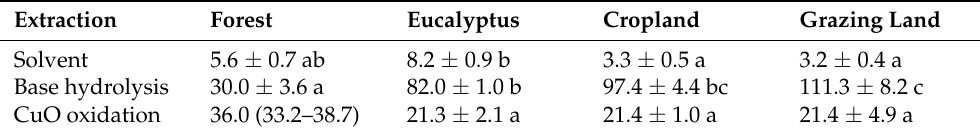
Figure 1. Carbon (C) and nitrogen (N) contents (%) at 0–10 cm soil depth in four land-use systems at Gelawdios, Ethiopia (mean ± SE, n = 10). Different lower-case letters indicate significant differences in soil C content; upper-case letters indicate significant differences in N content between land-use types. Note: 10-fold difference in axis scales between C and N contents. Table 1. Normalized yields (mg g − 1 C) of the three extraction methods from soils of different land-use systems in Gelawdios, Ethiopia. Shown are the mean and range (in parentheses) for the natural forest and mean ± SE ( n = 3) for the other land-uses. Different letters indicate a significant difference between land-uses ( p ≤